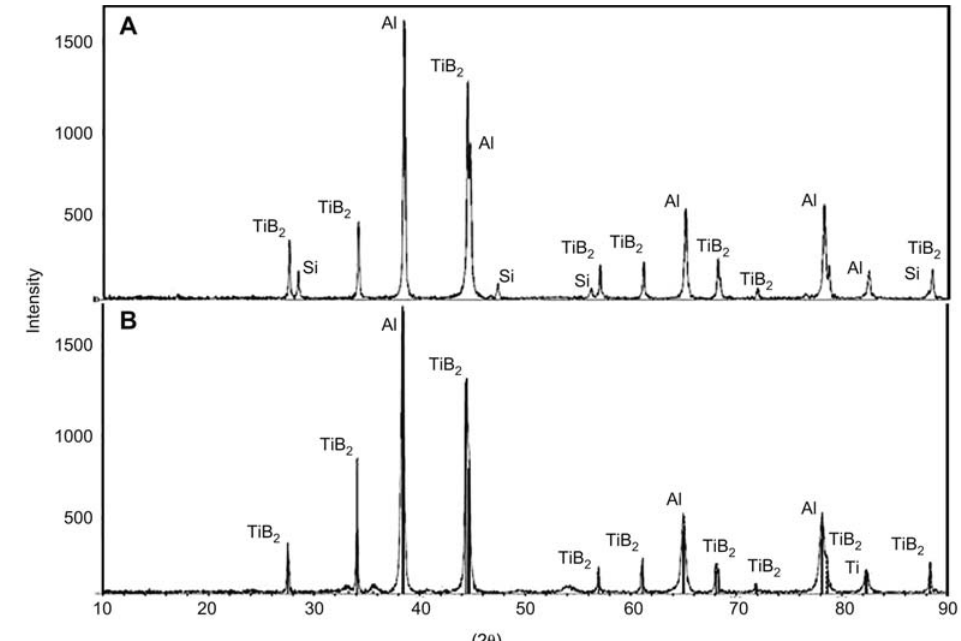
Figure 4 XRD results of (A) A356 and (B) Al matrix composites.